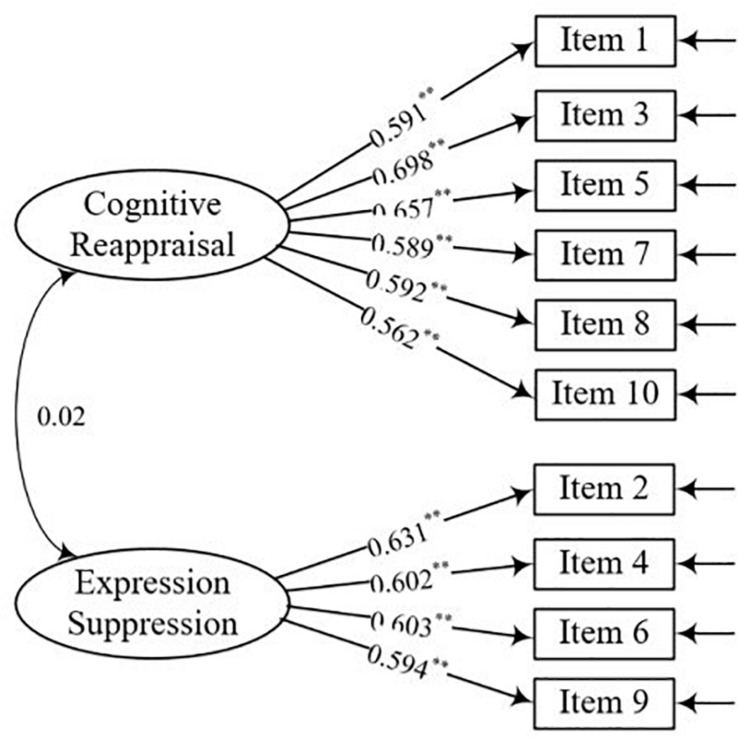
Standardized factor loadings for total sample confirmatory factor analysis (CFA).